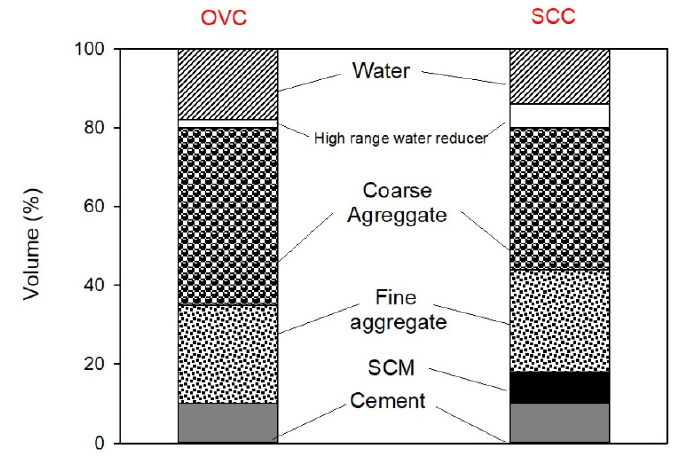
Figure 1. Mixture proportions of OVC and SCC (in % volume).